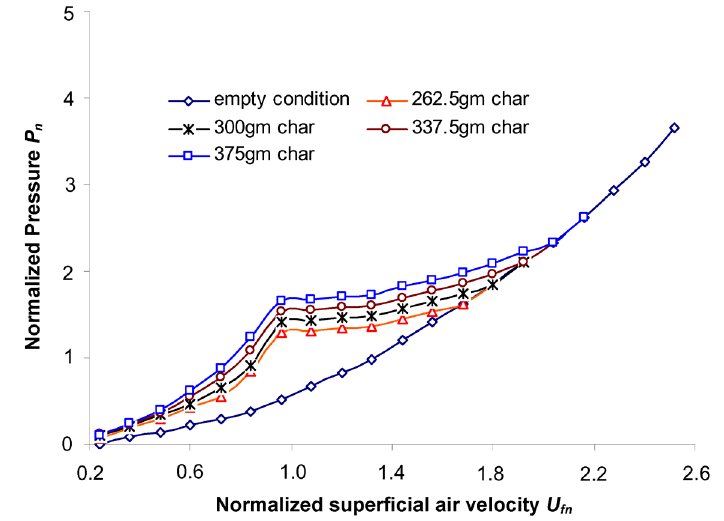
Fig. 4: Pressure difference on upper side of the distributor plate, P superficial air velocity, U